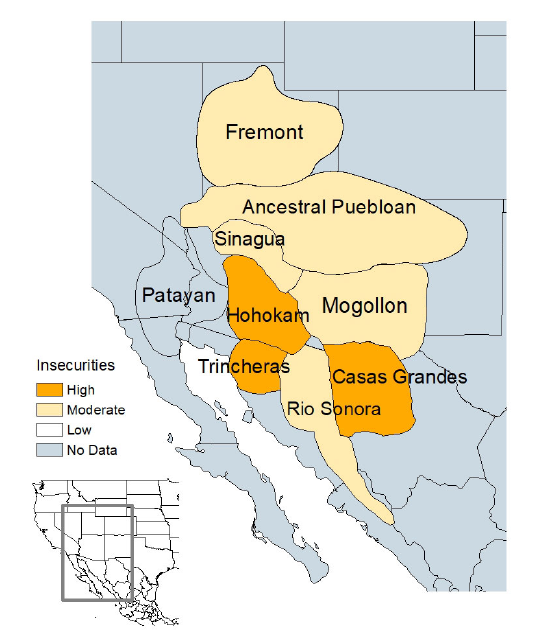
Fig. 8 . Political insecurity prior to depopulation (indicator: increasing social